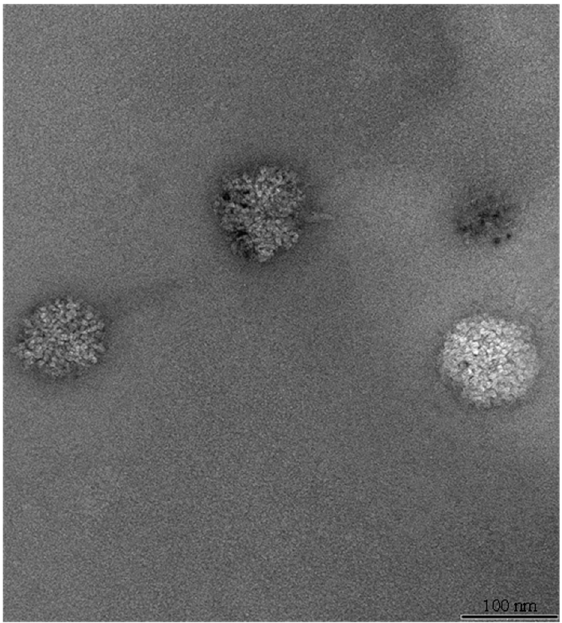
Figure 18. Structure of macromolecular aggregates found by TEM analysis of poly-4’,6-MOEG-9-TM- BF3k solutions in water. The scale bar corresponds to 100 nm.